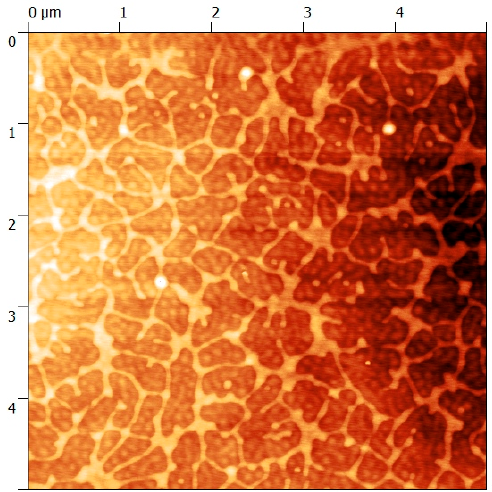
Figure 4. AFM image of a membrane obtained from a micellar solution of 20 wt % of PMMA-b-PSBMA block copolymer solution in TFE:water mixture (87:13% in volume) casted on the surface of a commercial hydrophobic PVDF membrane using a 250 µm casting knife.